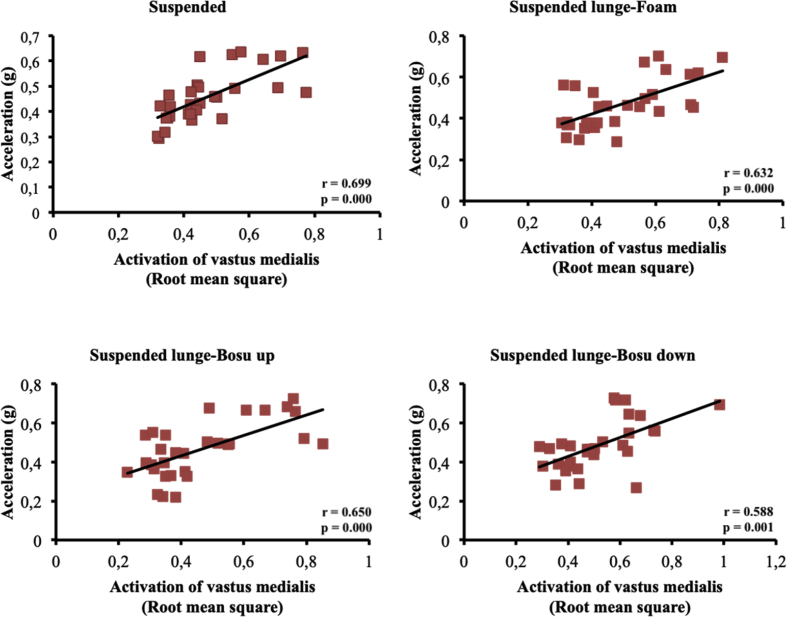
Correlation between vastus medialis activation and acceleration values under suspended lunge conditions.